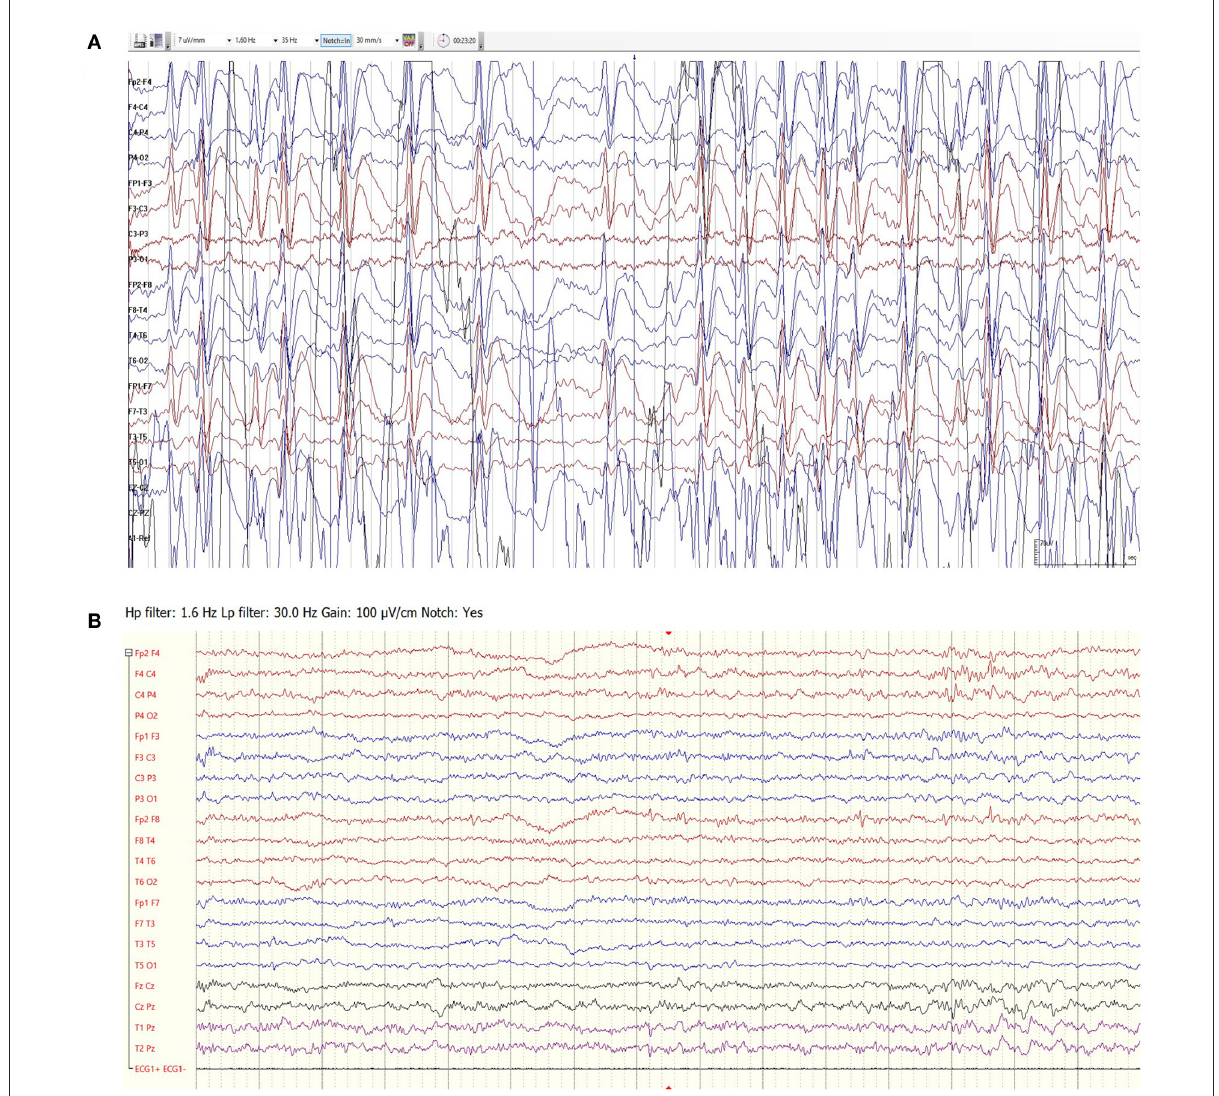
FIGURE2 EEG recordings of a 7.5-year-old girl with idiopathic ESES prior to felbamate treatment (A) and following 3 months of treatment (B) . The response lasted 10